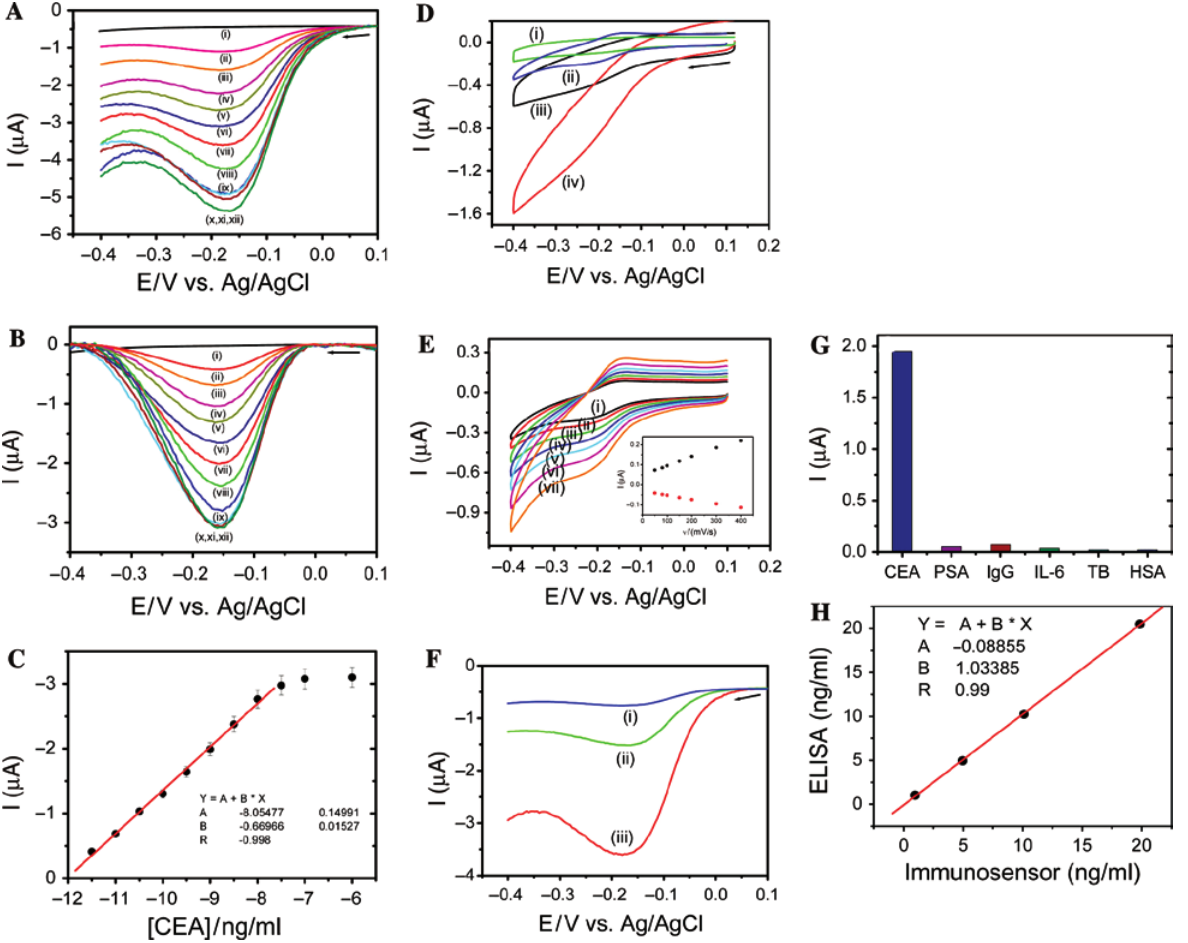
Figure 2: Electrochemical measurements of CEA immunosensor (A) recorded responses of square wave voltammetry (SWV) responses obtained for Au/Cys/Den/AuNP/Th-based CEA immunosensors at (i) blank noise and at different concentrations of CEA: (ii) 10 pg/ml to (xii) 1.0 μ g/ml. (B) Responses of SWV with subtracted background and (C) the related calibration plot. (D) Recorded responses of CV obtained for Au/Cys/Den/Th-based (i, iii) as well as Au/Cys/Den/AuNPs/Th-based (ii, iv) CEA immunosensors in a PBS solution of 0.1 m in the absence (i, ii) or presence (iii, iv) of 1.0 mm glucose. (E) Recorded currents of redox peaks vs. scan rate dependence and (F) recorded responses of SWV for Au/Cys/Den/AuNPs/Th-based CEA immunosensor in a PBS solution of 0.1 m (i) and in a glucose solution of 1.0 mm in the presence of (ii) Au/Cys/Den/Th- and (iii) Au/Cys/Den/AuNP/Th-based CEA immunosensors. (G) The bar graph compares SWV responses of Au/Cys/Den/AuNP/Th-based immunosensors toward CEA and other proteins, which reveals high selectivity of the sensor, and (H) the correlation response plot between the immunosensor and ELISA methods, which proved the agreement between two approaches. Reprinted with permission from Ref. [79]; copyright 2013, American Chemical